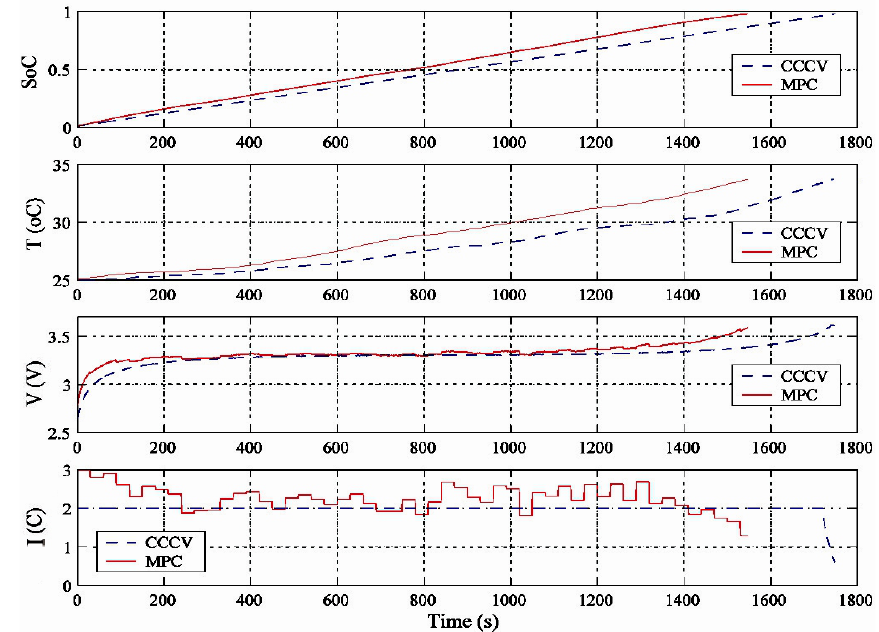
Figure 11. Experimental curves during the CCCV and MPC charging processes using a modified 2 C